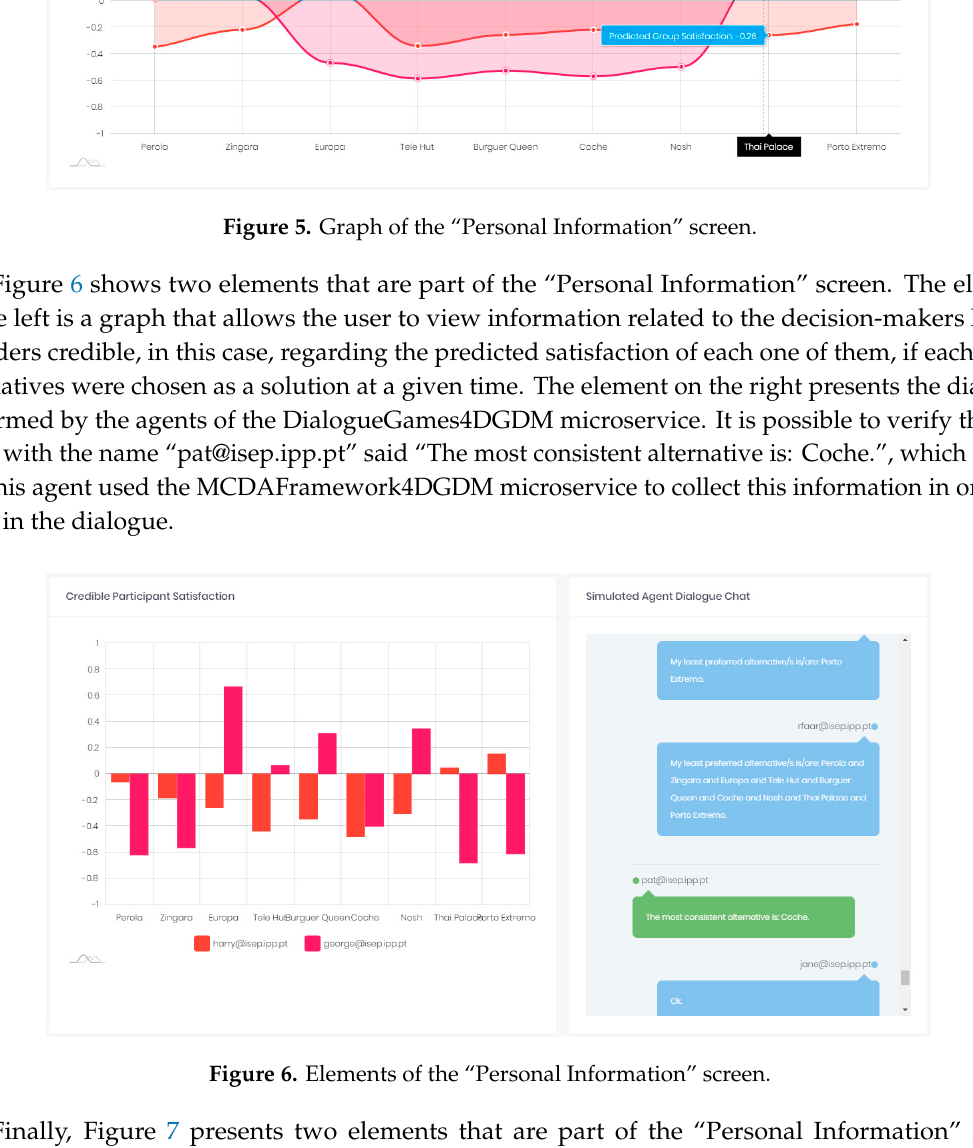
Figure 7. Elements of the “Personal Information” screen. 6. Conclusions and Future Work To support GDM processes when participants are dispersed is a complex task. There are several approaches that consist of proposing possible solutions according to the decision-makers’